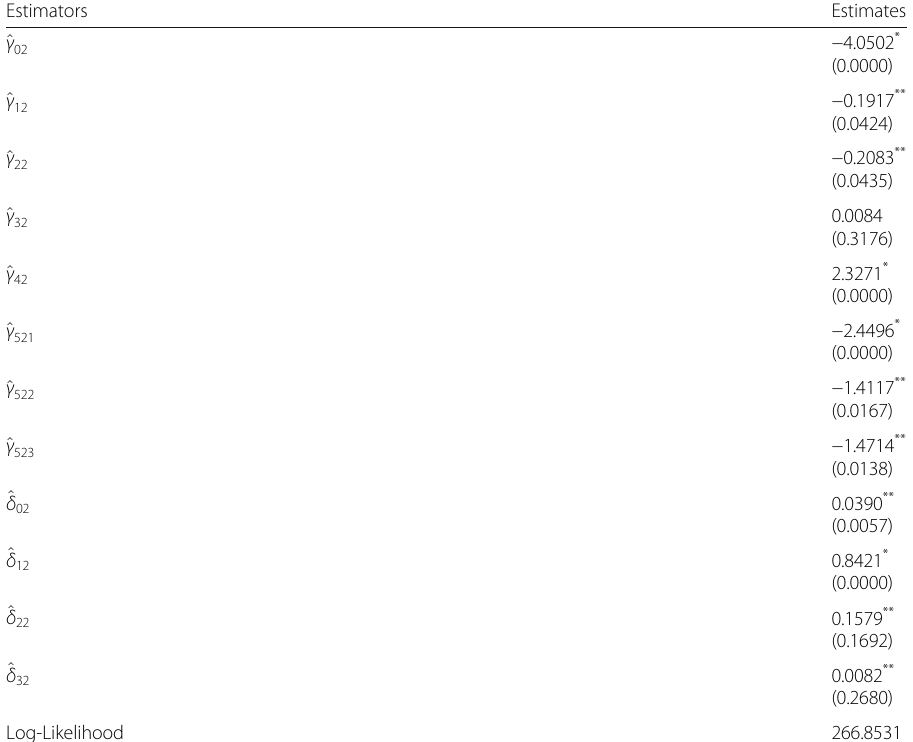
Table 5 Second stage V-IGARCH(1,1) regression model (Equation 4) Estimators